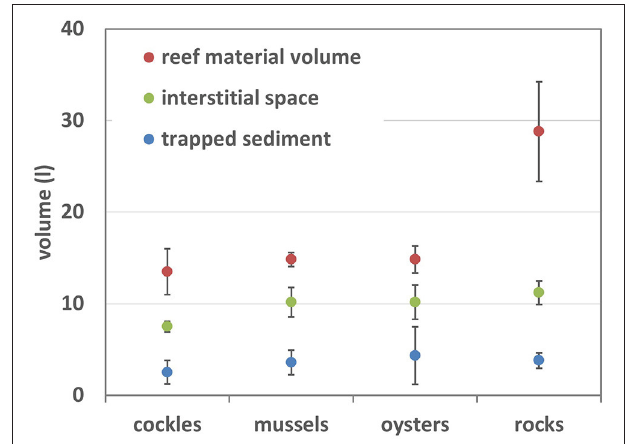
FIGURE 3 | Abiotic properties of experimental reef-units: volume of shell and rock material within each sample unit, interstitial space within the units and amount of trapped sediment.